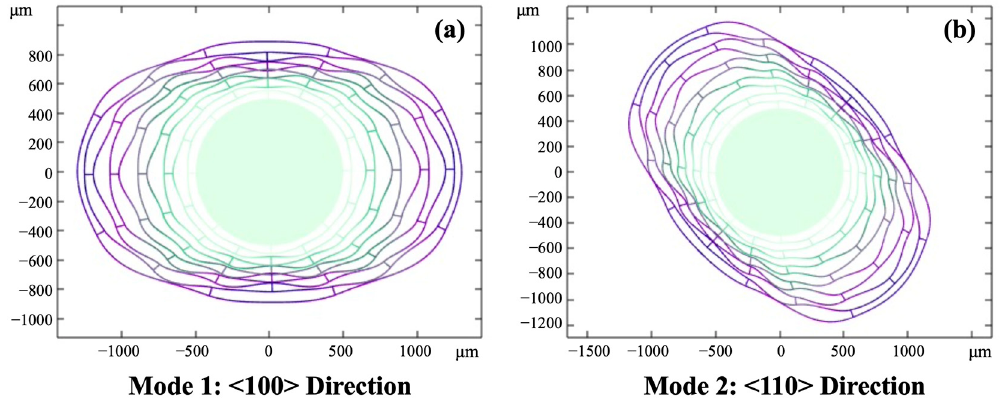
Figure 1. Wineglass vibration modes of a multi-ring disk resonator along ( a ) <100> direction (Mode 1) and ( b ) <110> direction (Mode 2). 1) and ( b ) <110> direction (Mode